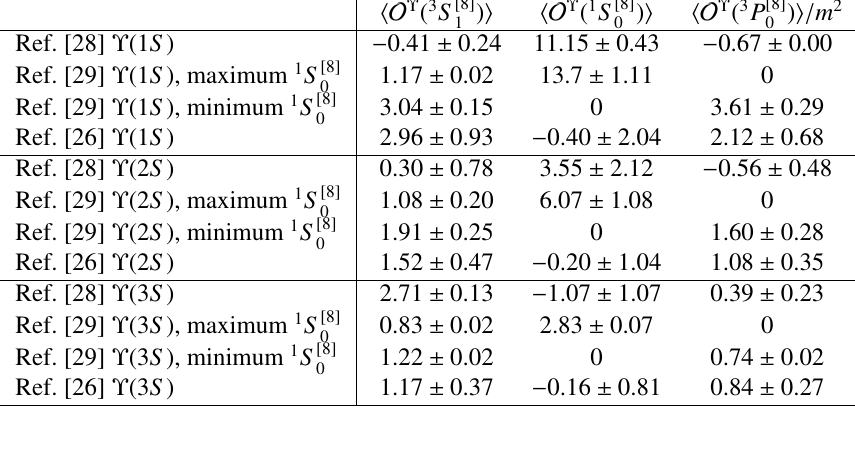
Table 3. Phenomenological determinations of Υ color-octet matrix elements in units of 10 − 2 GeV 3 from refs. [26, 28, 29]. The analysis in ref. [28] employed a smaller NRQCD scale of 1 . 5 GeV whereas in refs. [26, 29] the scale was chosen to be the bottom quark mass m b . Due to the running of the 3 S [8] matrix element, at the scale m b the values of ⟨O Υ ( 3 S [8] ) ⟩ from ref. [28] will be more negative 1 1 for Υ (1 S ) and Υ (2 S ), and more positive for Υ (3 S ) compared to what are listed in this table. It is also worth noting that the treatment of P -wave feeddowns in ref. [28] are inconsistent with measurements in ref. [30], which became available after ref. [28] was published. In ref. [29], only two linear combinations of the three matrix elements are determined, and the maximum ranges of the matrix elements are obtained from maximizing and minimizing ⟨O Υ ( 1 S [8] ) ⟩ under the assumption that the 0 matrix elements are positive definite similarly to what has been done in ref. [21]. Ref. [26] provides covariance matrices from which the correlations in the uncertainties can be obtained. The pNRQCD results from ref. [26] are from the analysis with p T larger than 5 times the heavy quarkonium mass; the pNRQCD results for Υ (1 S ) matrix elements are obtained by assuming the results in the strongly coupled pNRQCD formalism developed in refs. [15–17] also applies to the 1 S state. ⟨O Υ ( 3 S [8] ) 1